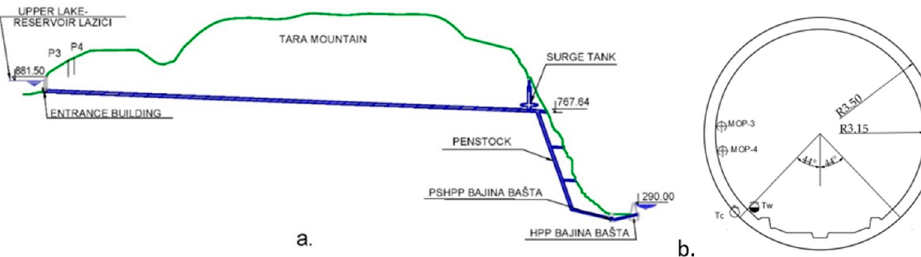
Figure 2. Map of Serbia showing the river Drina and the position of the PSHPP Bajina Bašta.